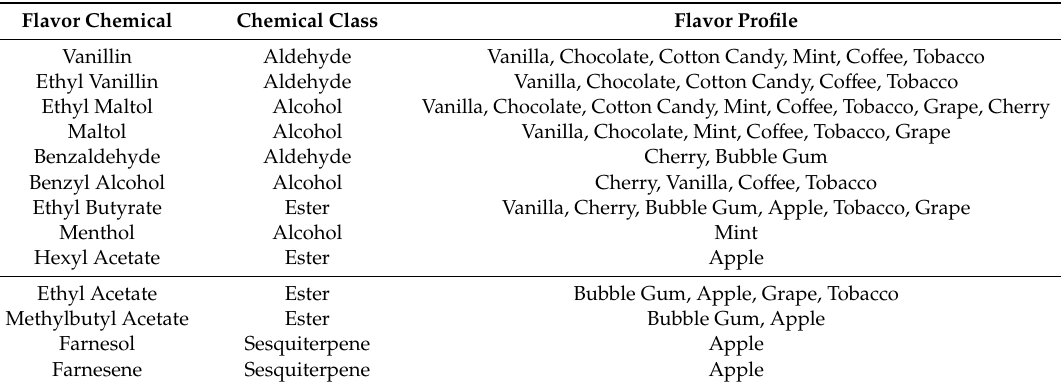
Table 2. Popular flavoring chemicals in e-liquids.